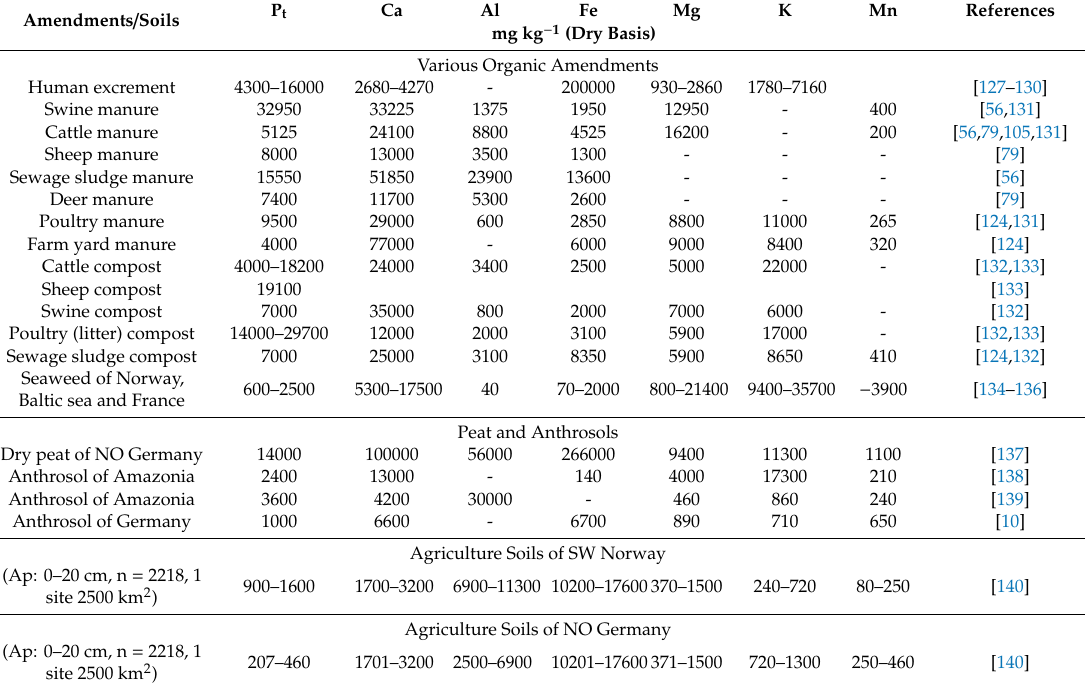
Table 5. Total element concentrations as reported in literature for various soil amendments, peat, Anthrosols, and surrounding agriculture soils of the respective region of the Anthrosols under study. Amendments /